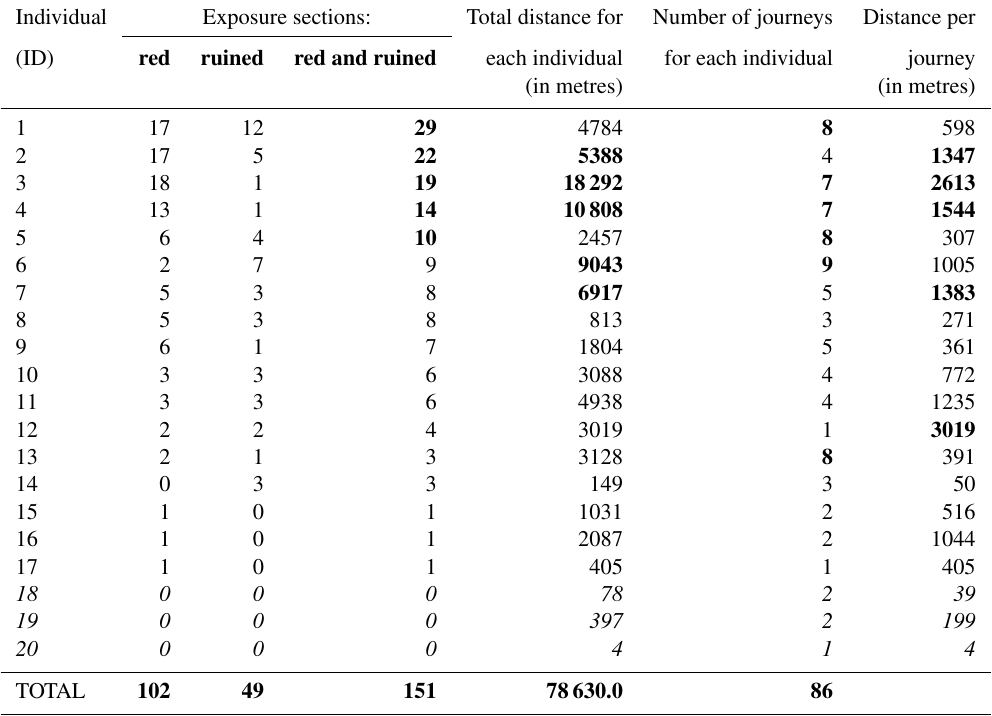
Table 1. This table summarises the spatial convergence between people’s mobility after the second, main shock and the weakened buildings following this shock. Italic rows correspond to individuals who never travelled through an impact area. The boldface indicates the five highest values in each